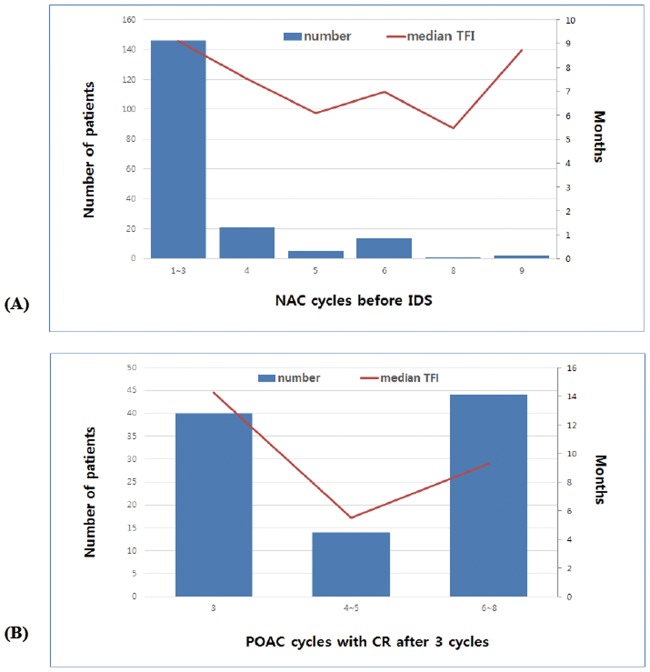
Linear trends analyses for the median TFI as the number of NAC/POAC cycles increases.The tendency of the median TFI according to (A) the timing of interval debulking surgery and (B) the number of POAC cycles in patients with complete remission after 3 cycles. TFI: treatment-free interval; NAC: neoadjuvant chemotherapy; POAC: postoperative adjuvant chemotherapy.